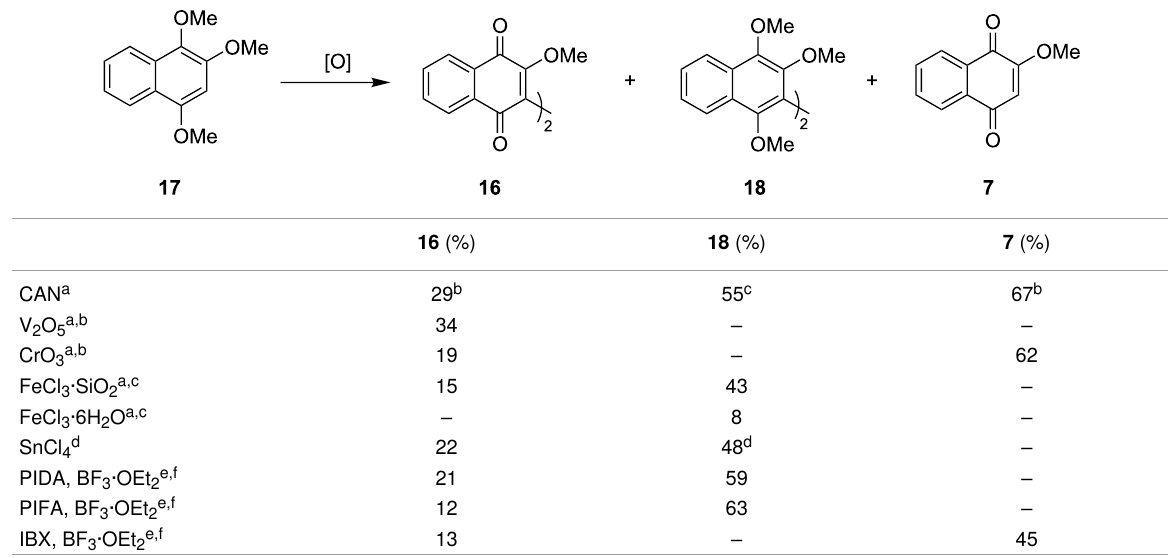
Table 1: Reagents and products in the oxidative dimerization of 1,2,4-trimethoxynaphthalene ( 17 ).